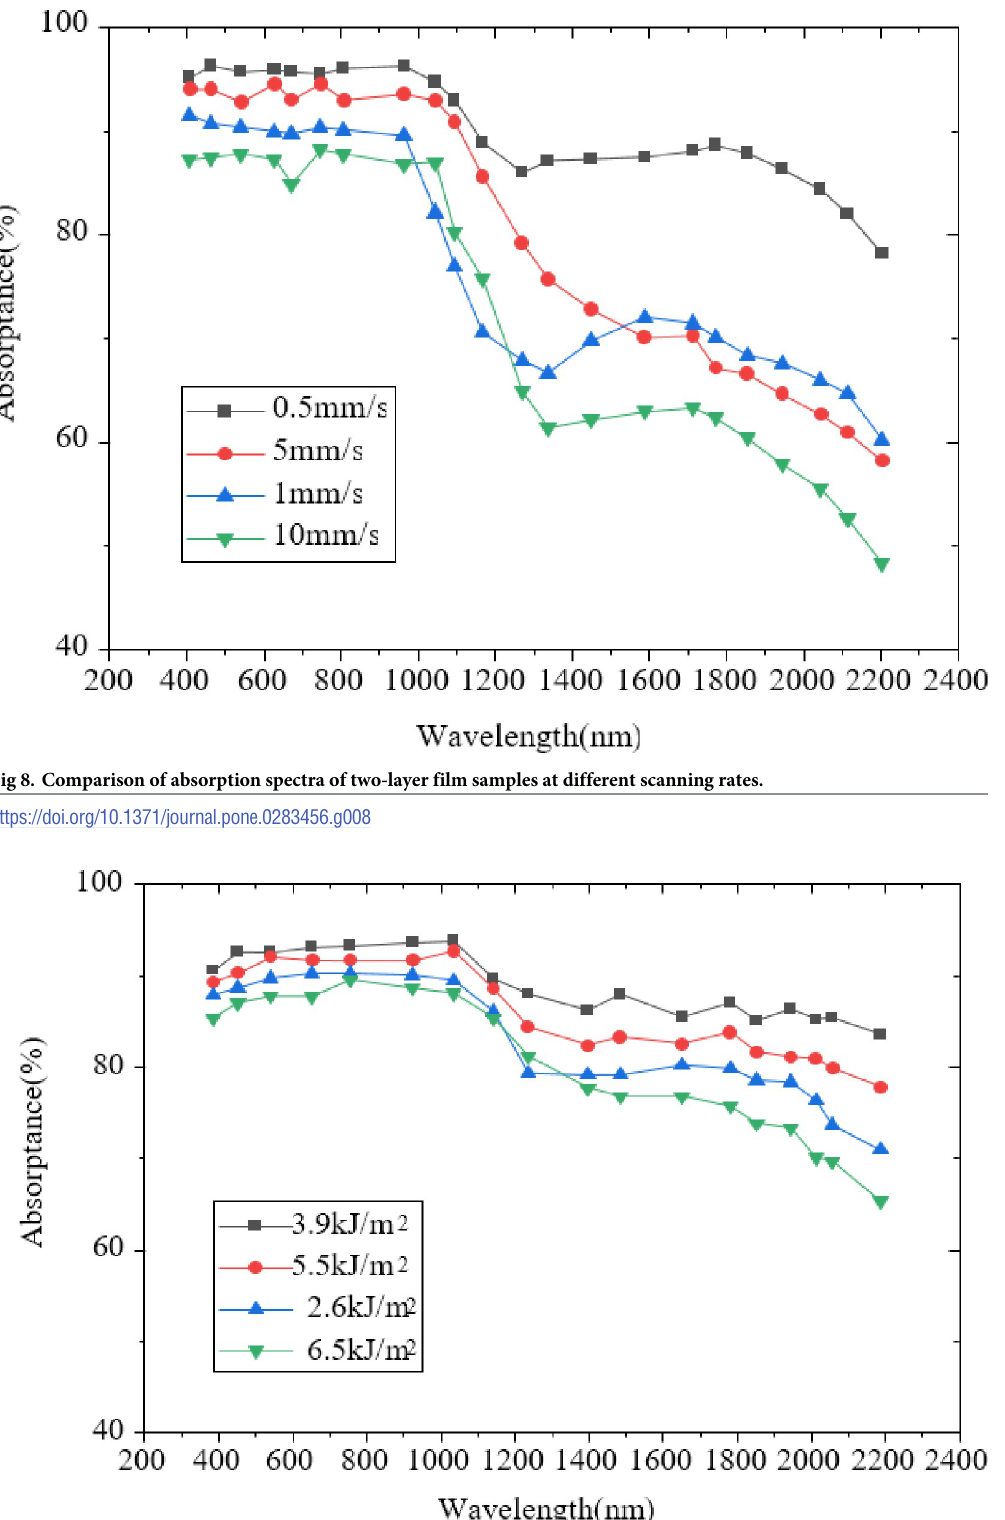
PLOS ONE | https://doi.org/10.1371/journal.pone.0283456 March 27,